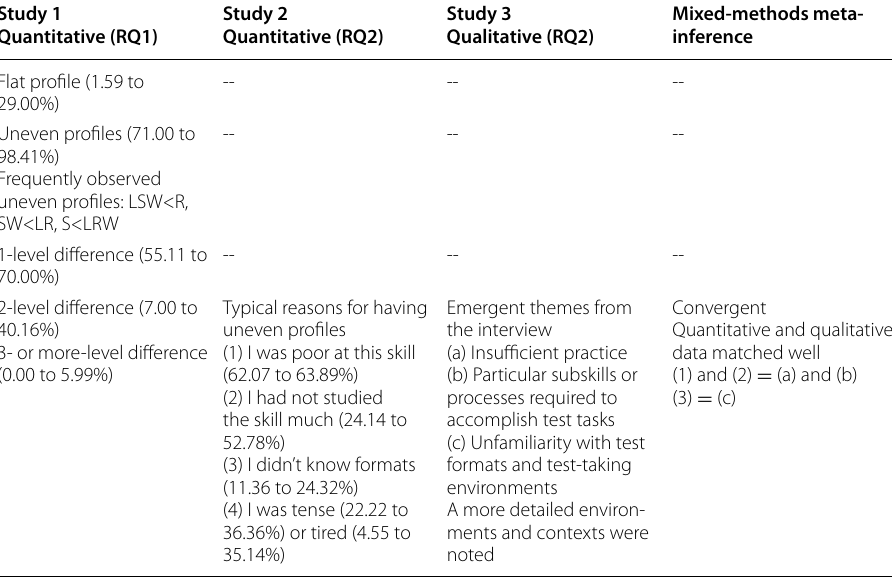
Table 12 Joint display of the current study’s results Study 1 Quantitative (RQ1)